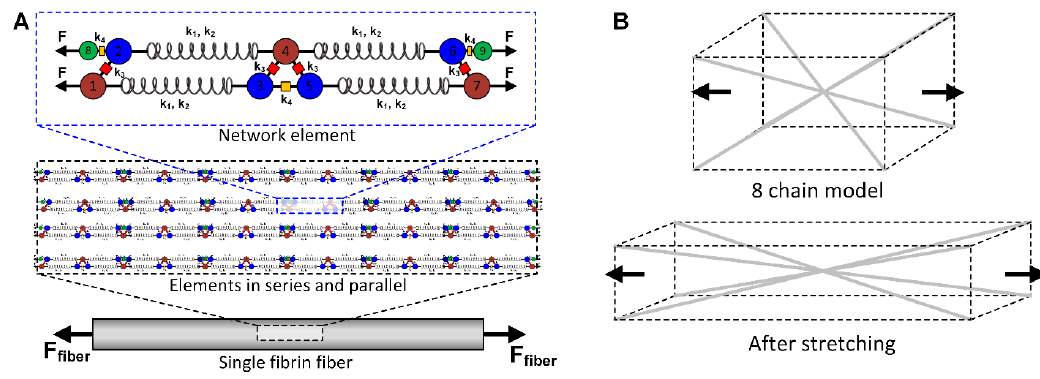
Figure 8. ( A ) Arrangement of network model element (Model 2) in series and parallel to form a fibrin fiber subjected to an externally applied force. ( B ) Schematic of the eight-chain model (Model 3) used for fibrin clot modeling (the diagonal connecting lines represent the fibrin fibers).